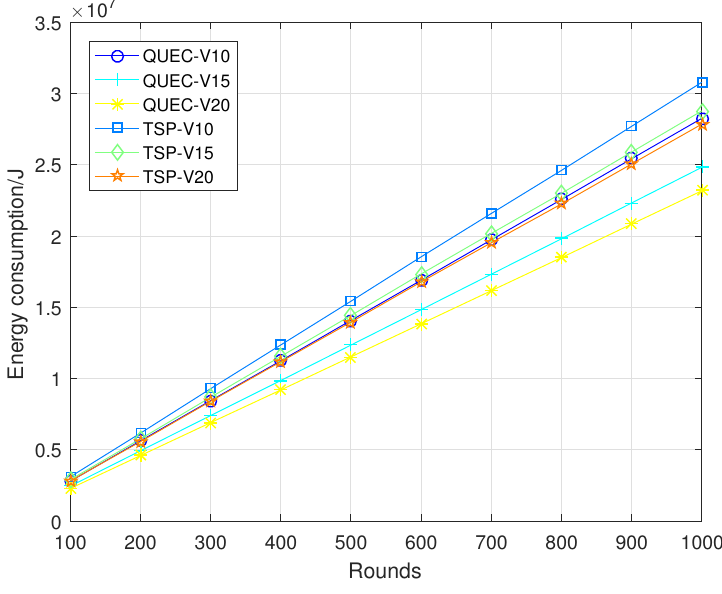
Figure 7. Energy